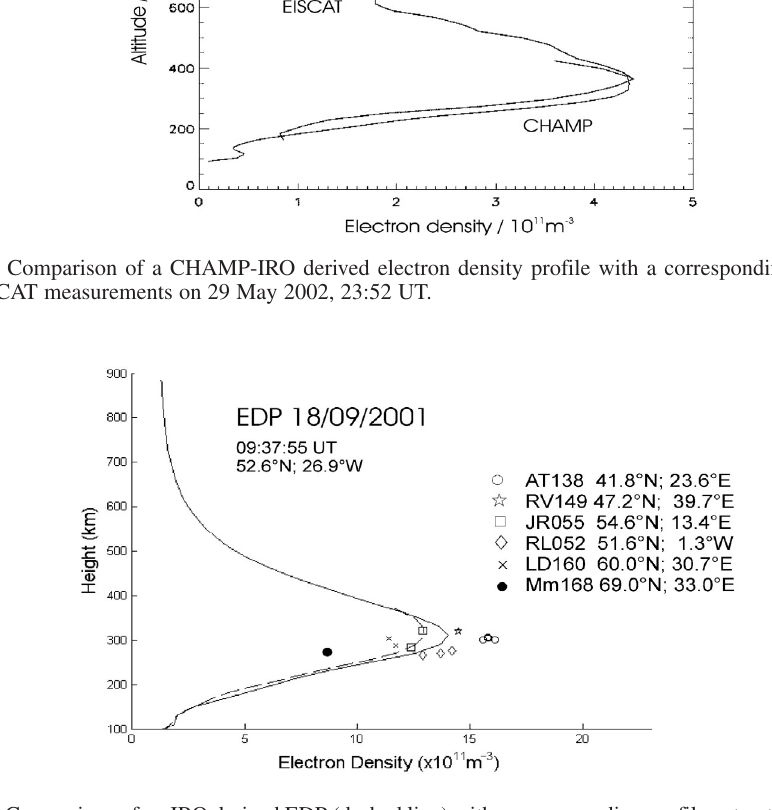
Fig. 7.6. Comparison of an IRO derived EDP (dashed line) with a corresponding profile extracted from the MI- DAS reconstruction. Comparison with NmF 2 data from various European ionosonde stations is indicated by the symbols. 1056